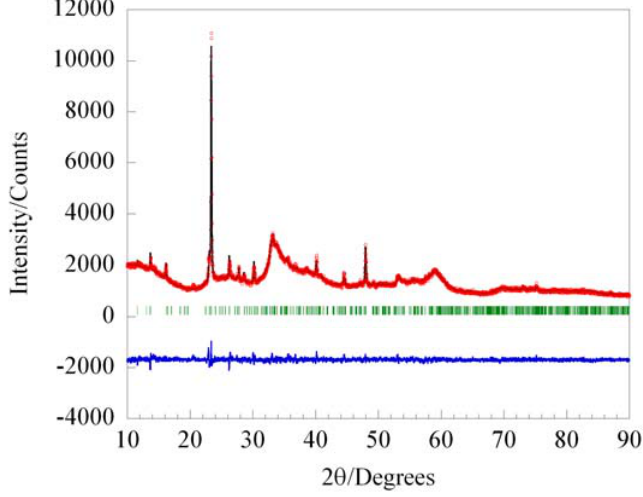
Figure 8. Le Bail fit the new WS Å, b = 3.076 Å, c = 11.104 Å and  =